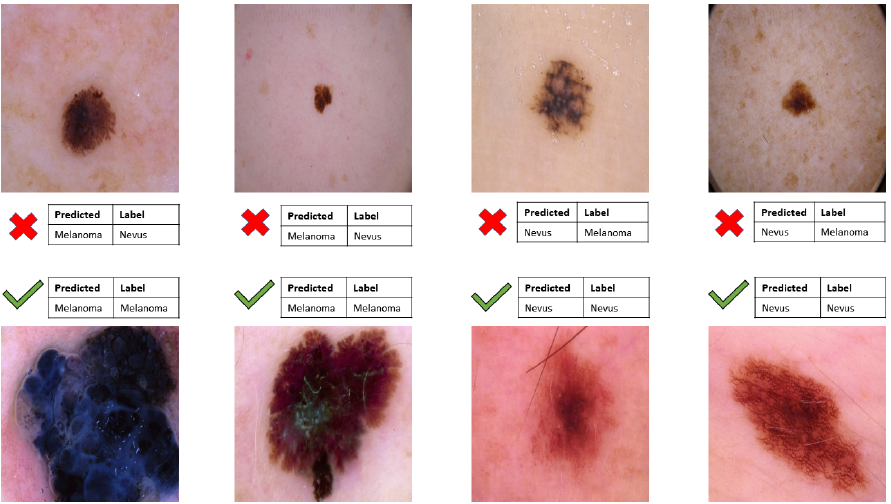
Figure 17. Model ability to classify melanoma and